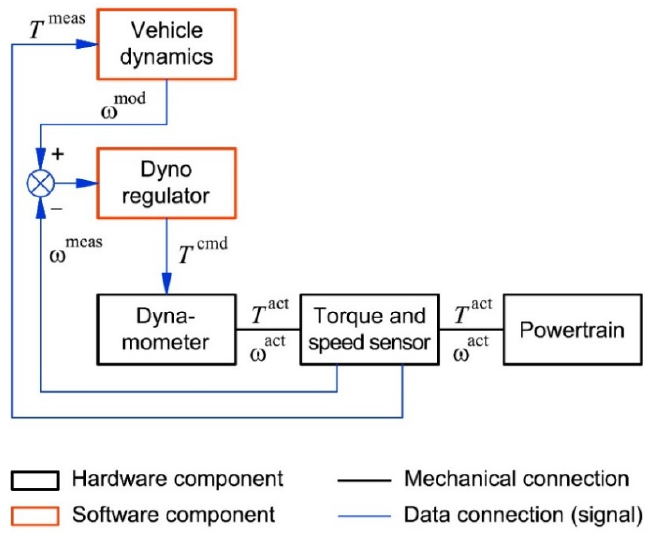
Figure 1. Hardware arrangement, simulation and control loops of a component-in-the-loop (CiL) system for powertrain testing with modeling of a “lumped” vehicle neglecting tire slip.